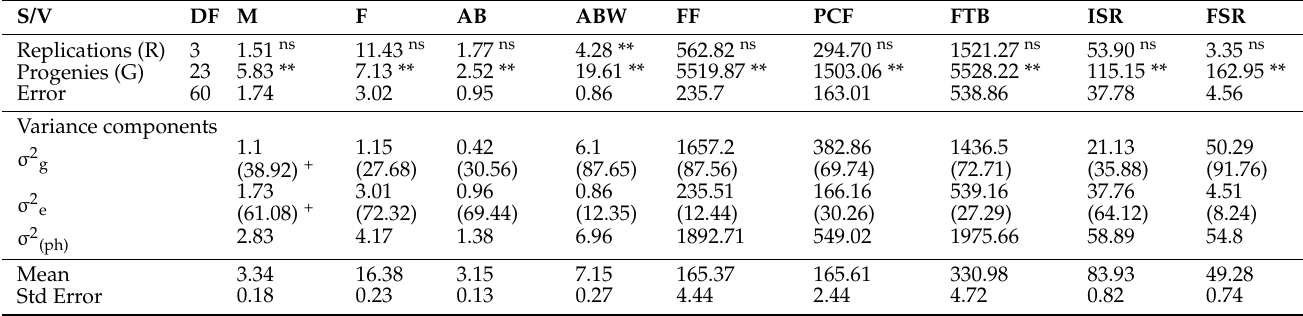
Table 2. ANOVA and variance components of D × P biparental progenies for sex ratio, and other